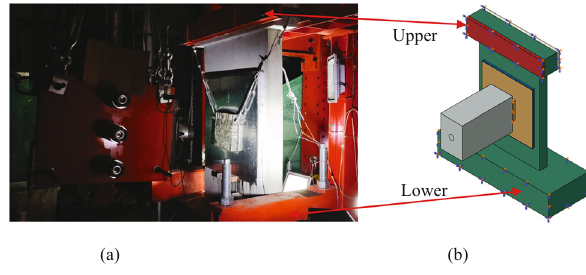
Figure 2: Pendulum impact test. ( a ) Pendulum test and ( b ) numerical model.